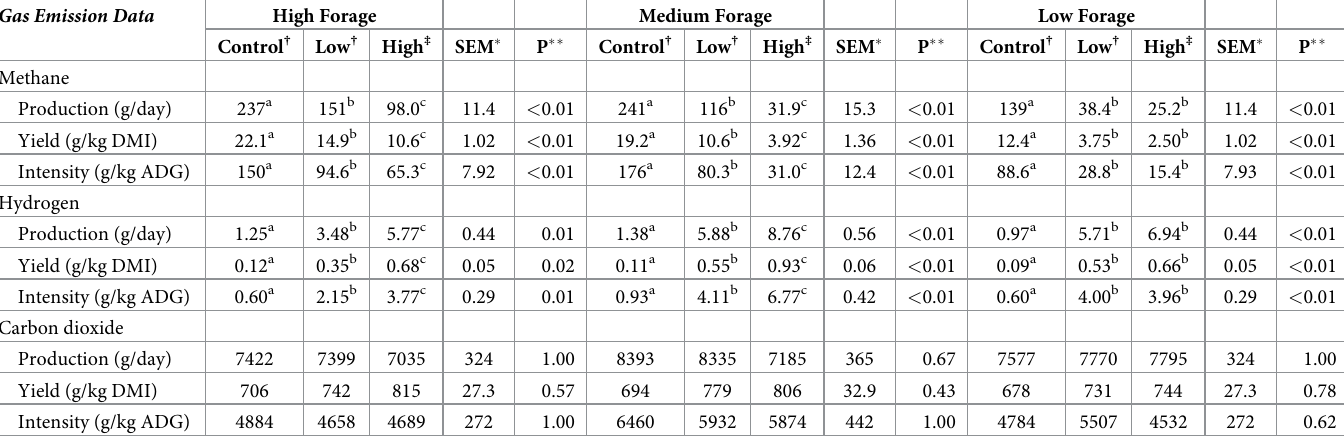
Table 3. Effect of Asparagopsis taxiformis inclusion at 0.25% (Low) and 0.5% (High) feed organic matter on enteric gas emissions using high-, medium-, and low- forage